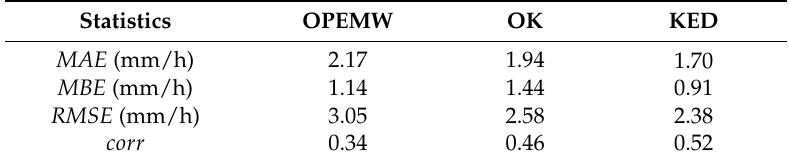
Table 3. Continuous statistics against rain gauge observations for original OPEMW data, and